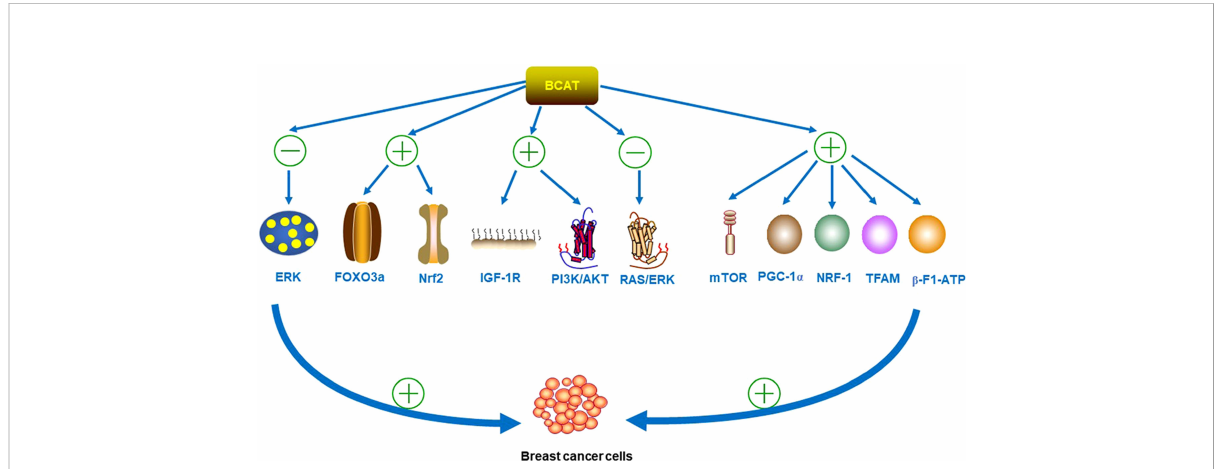
FIGURE 4 BCAT inhibits the phosphorylation of ERK and upregulates the levels of transcription factors FOXO3a and Nrf2 during the development of BC. BCAT1 also activates the PI3K/AKT axis by stimulating the IGF-1R signaling pathway, while downregulating the RAS/ERK pathway. In addition, BCAT1 also activates mTOR signaling and the expression of PGC-1 a , NRF-1, TFAM and b -F1-ATPase, all of which can promote the proliferation, migration and invasion of BC cells. “ + ” means promotion, “ - ” means